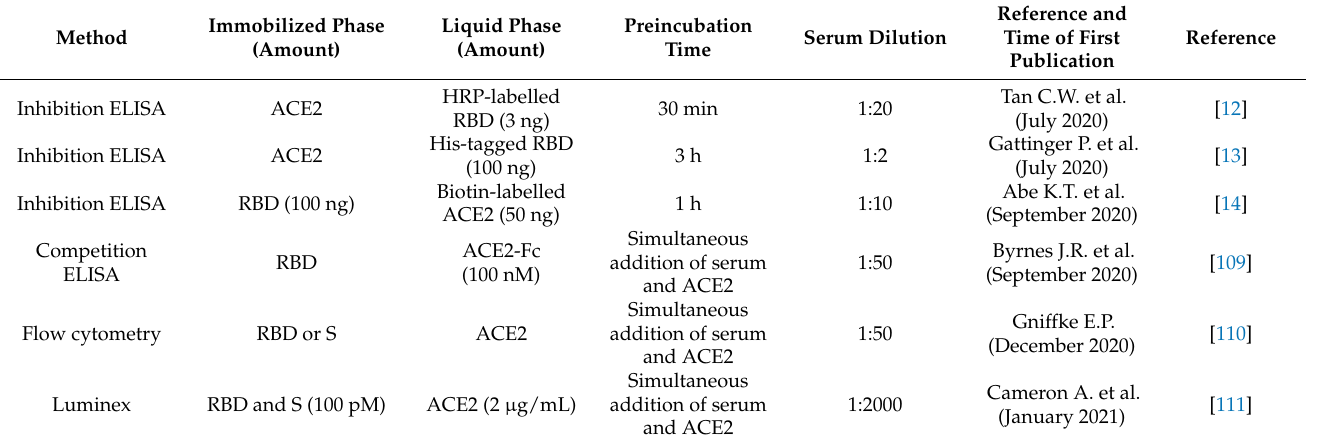
Table 2. Overview of first molecular interaction assays (MIAs) to detect antibodies inhibiting the ACE2–RBD